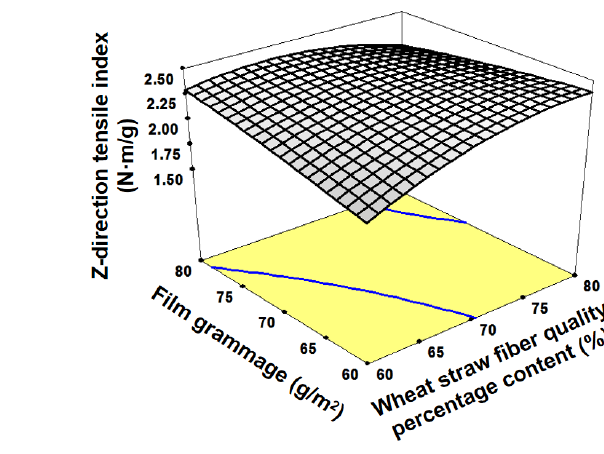
Figure 2. Response surface plot of factors affecting Z-direction tensile index: ( a ) Influence of beating degree of unbleached sulfate conifer pulp fiber and beating degree of wheat straw fiber on Z-direction tensile index; ( b ) Influence of wheat straw fiber quality percentage content and film grammage on Z-direction tensile index.